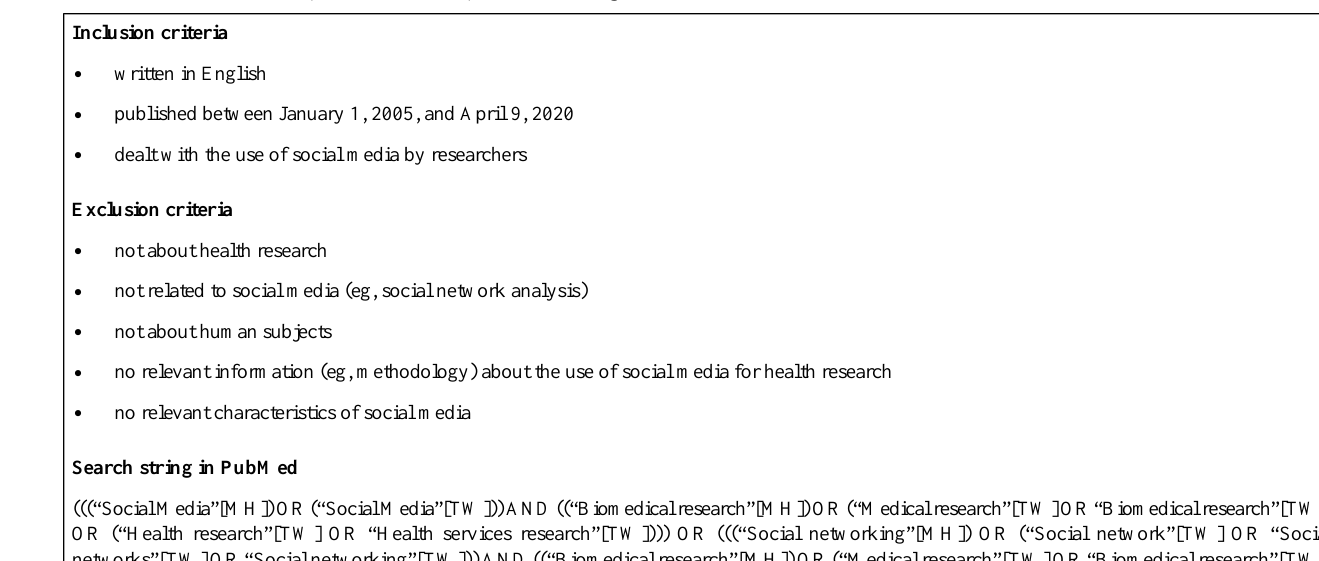
Textbox 1. Inclusion criteria, exclusion criteria, and search